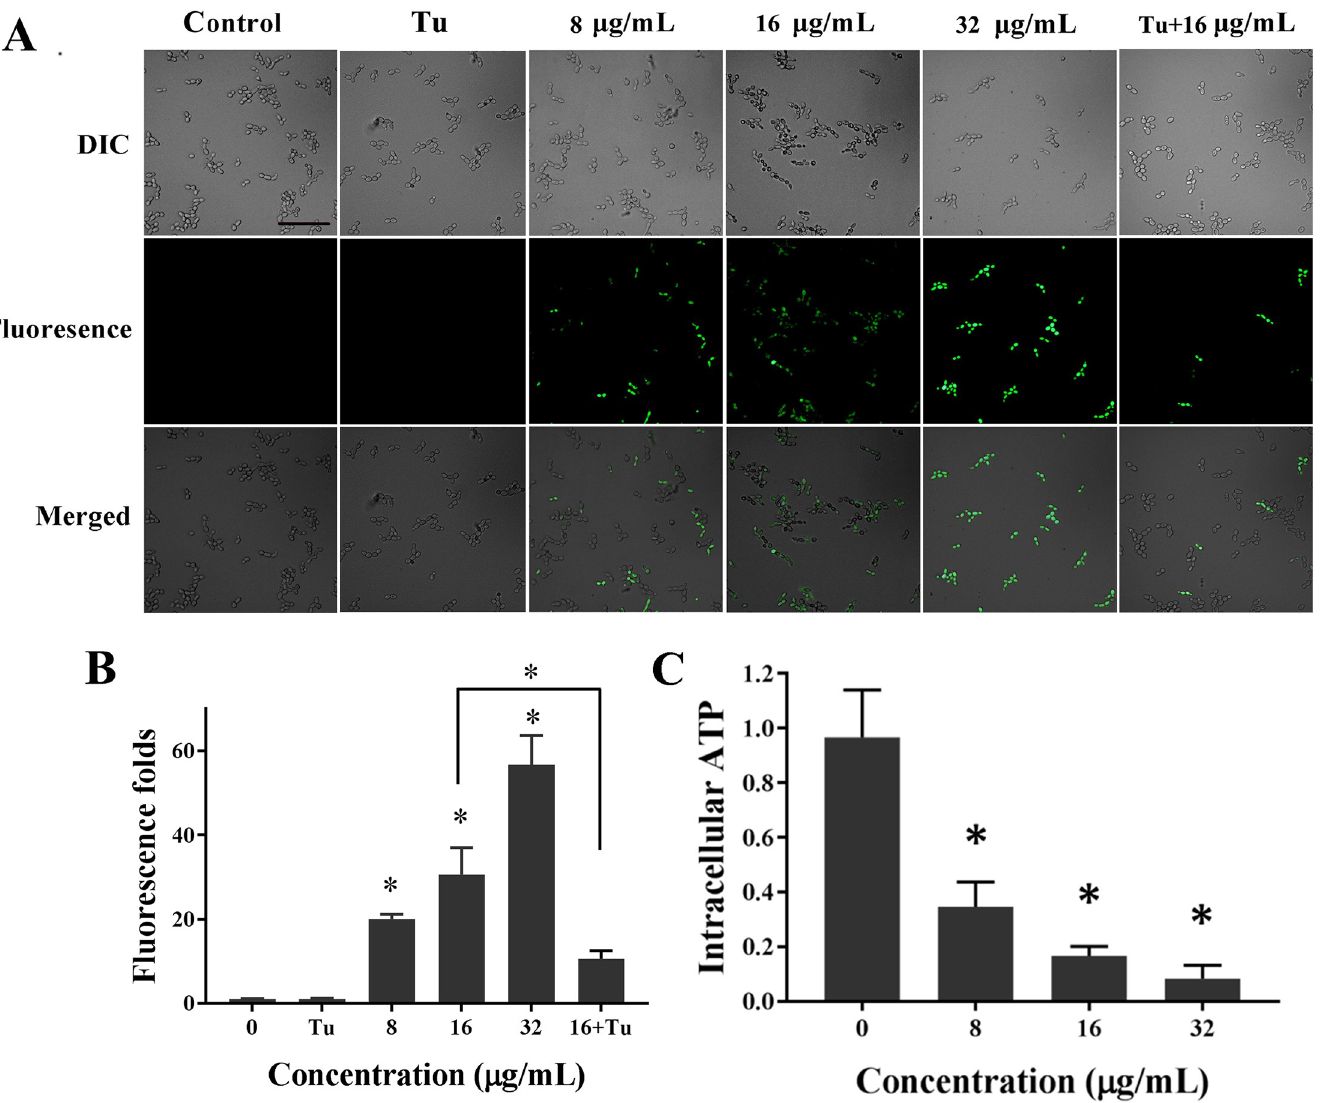
Fig 4. Effect of KPA on the mitochondrial function. (A) The fluorescence microscopic observation of C . albicans SC5314 with different treatments stained with Rh123. Bar, 50 μ m. (B) Change in relative fluorescence intensity of treated SC5314 cells was monitored by spectrofluorophotometry. (C) Intracellular ATP was extracted from cells treated with KPA or not and determined using an ATP assay kit. Each column in (B) and (C) represents the mean values of each group, and error bars show standard deviations. � means statistically significant difference ( P < 0.05).